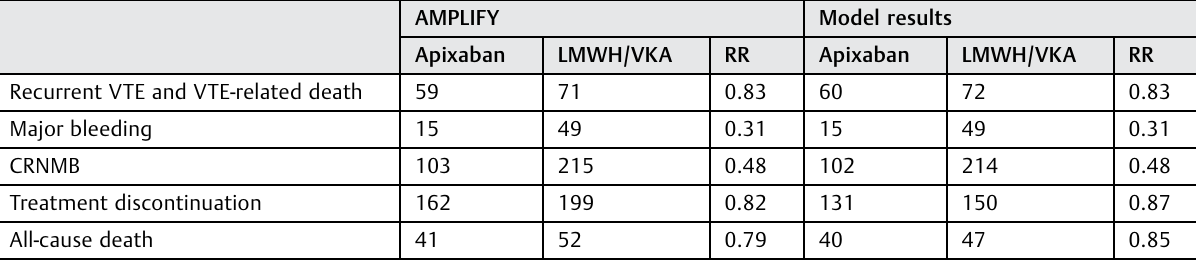
Table 4 Model validation comparing the results of the model to the AMPLIFY trial outcomes AMPLIFY Model results Apixaban LMWH/VKA Apixaban